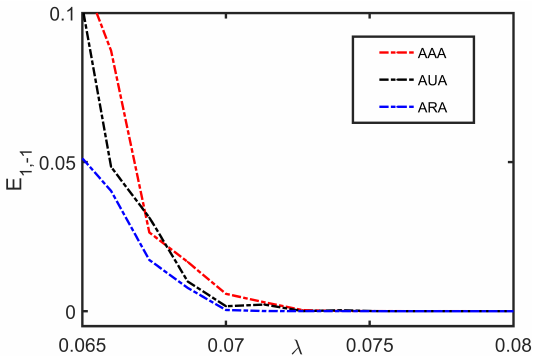
Figure 2. Synchronization error E 1, − 1 between the outer layers ( k = 1, k = − 1 ) as a function of inter-layer coupling strength λ for the fixed value of intra-layer coupling σ = 0.02. Red, black, and blue dashed curves represent the synchronization errors for AAA, AUA, and ARA